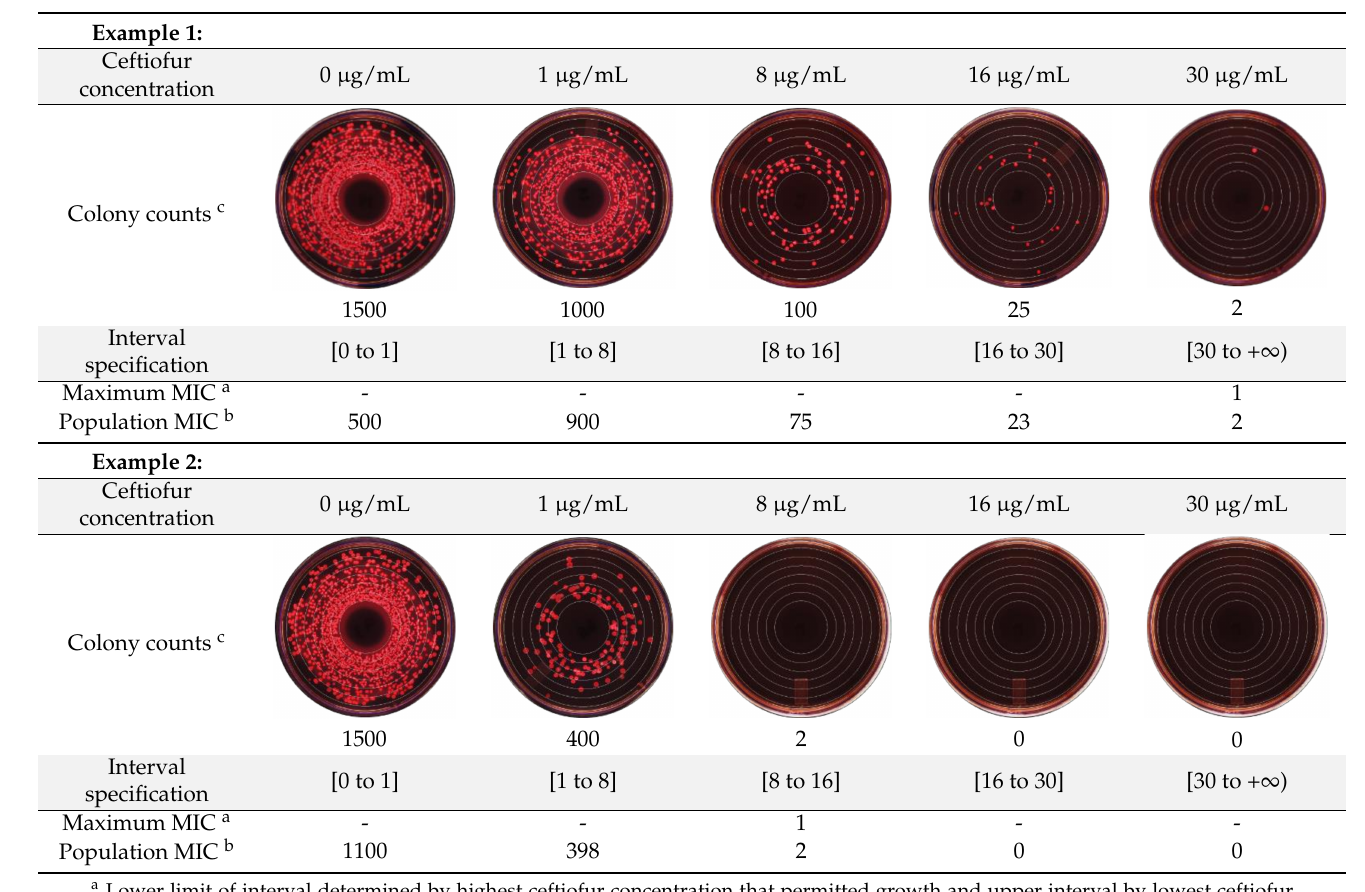
Table 1. Example determination of interval values for the multilevel mixed effects interval regression model for ceftiofur Minimum Inhibitory Concentration